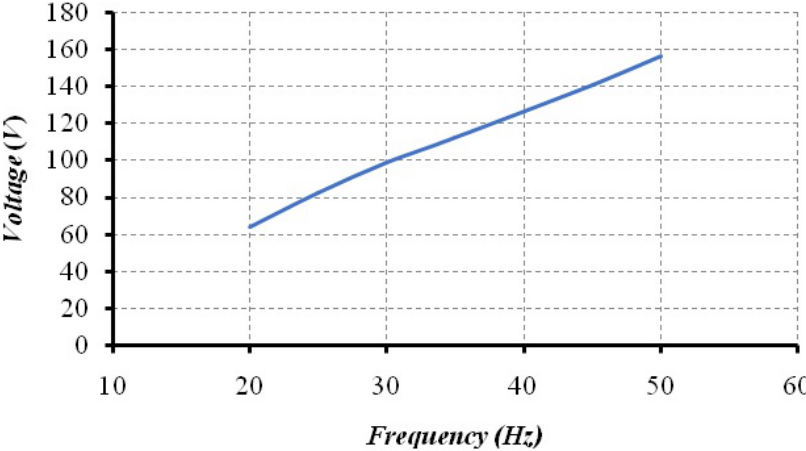
Figure 13. Measured motor voltage against frequency relationship.